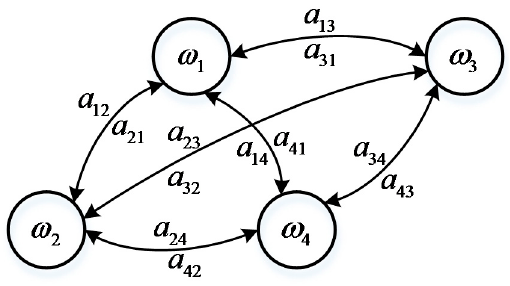
Figure 1. Discrete Markov Model.